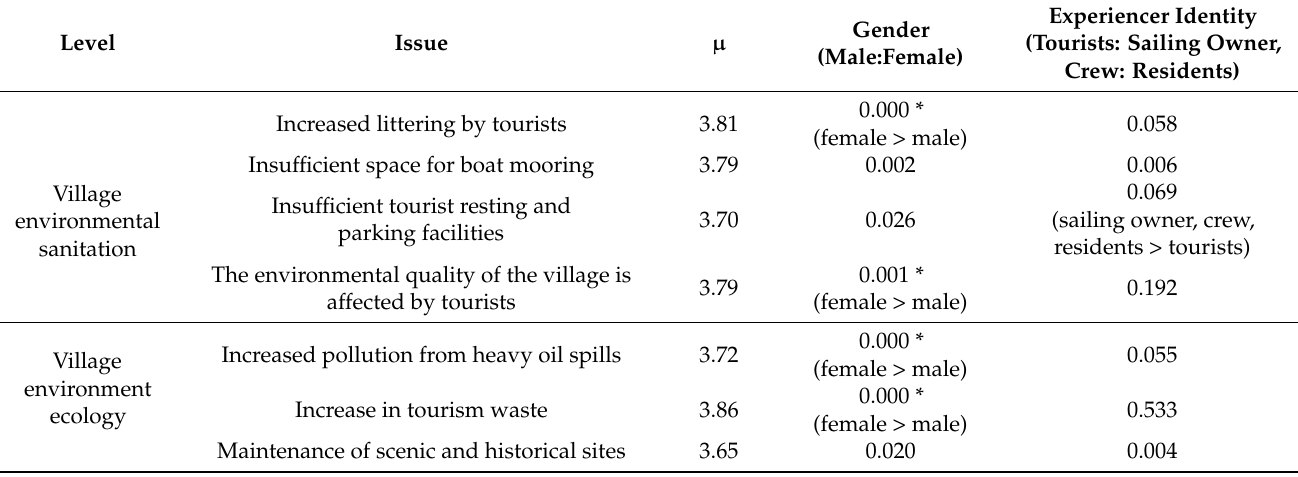
Table 6. Perception analysis of the impact on village environment